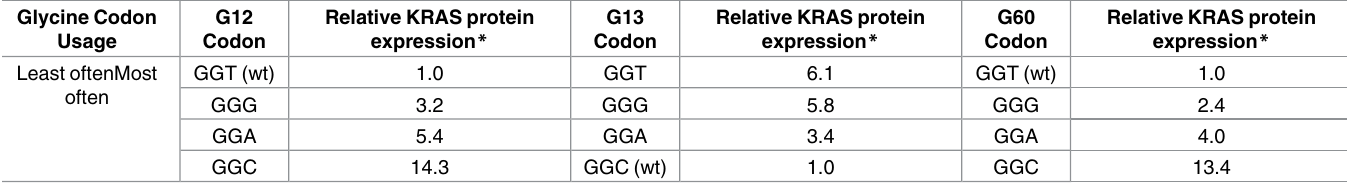
G13 Relative KRAS protein Codon expression *